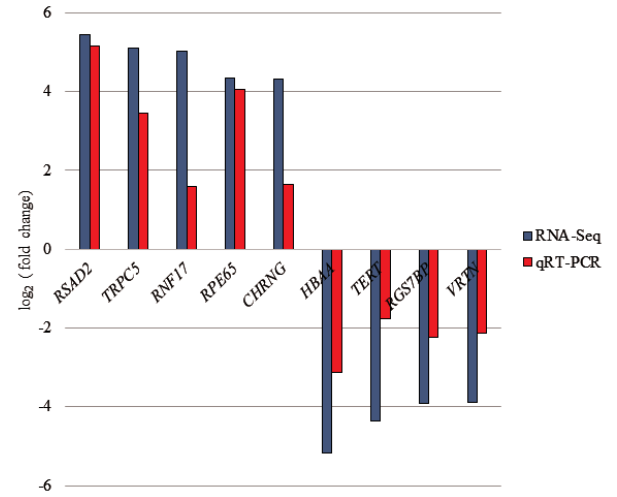
Figure 3. Illustrating of qRT-PCR validation for selected differentially expressed genes (DEGs). The selected genes were placed in X-axis and Y-axis represents log (fold change) from qRT-PCR and RNA- 2 seq. qRT-PCR, quantitative real-time polymerase chain reaction.